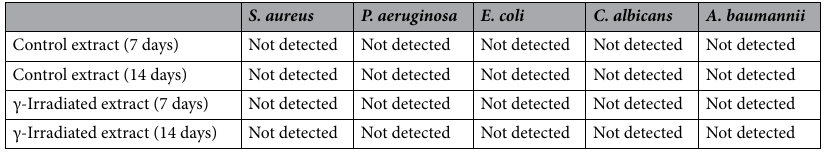
Table 1. Microbial growth assessment of the γ-irradiated hydrogel polymer filled with the control vs. γ-irradiated mixture of plant extracts from agrimonia, houttuynia, licorice, peony, and phellodendron (AHLPP)